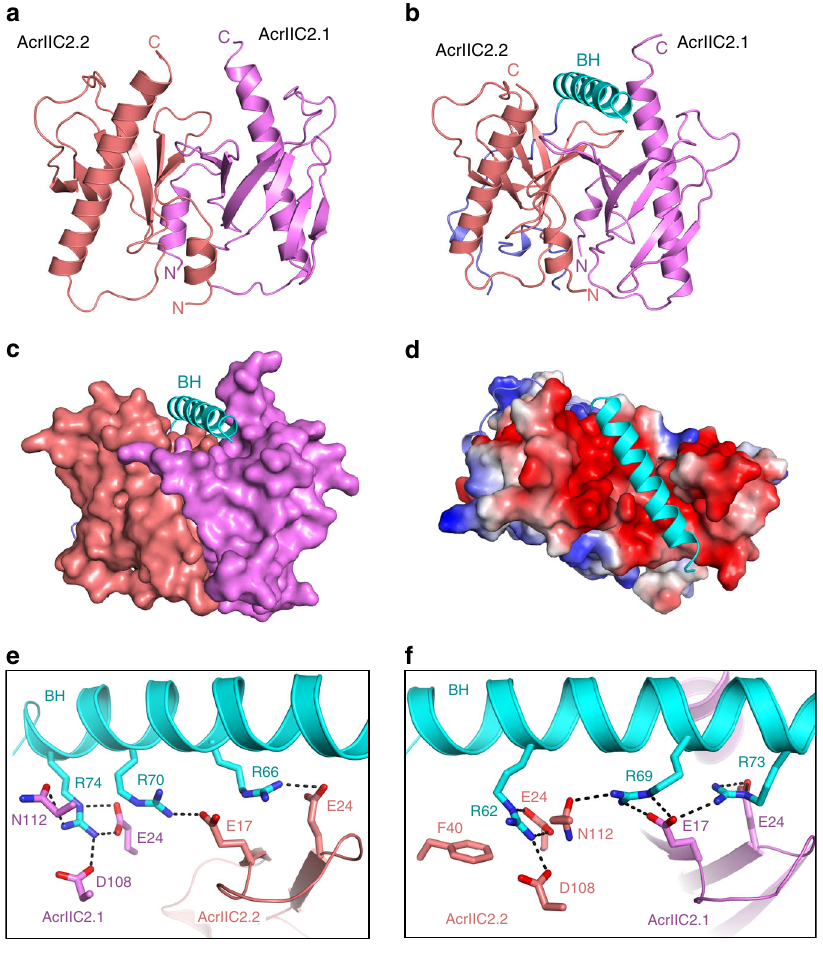
Fig. 3 AcrIIC2 Nme functions as a homodimer. a The crystal structure of AcrIIC2 Nme solved by Se-SAD reveals a dimeric protein containing both α -helical and β -strand structural elements. Monomers are colored in violet and deep salmon, and the N- and C-termini are noted. b Cartoon representation of AcrIIC2-Nme1Cas9 complex. c Surface representation of AcrIIC2-Nme1Cas9 complex. d Electrostatic surface potential of AcrIIC2-Nme1Cas9 complex. e , f Interactions between the bridge helix and AcrIIC2 Nme . The bridge helix is shown in cyan. AcrIIC2.1 and AcrIIC2.2 are shown in violet and deep salmon,